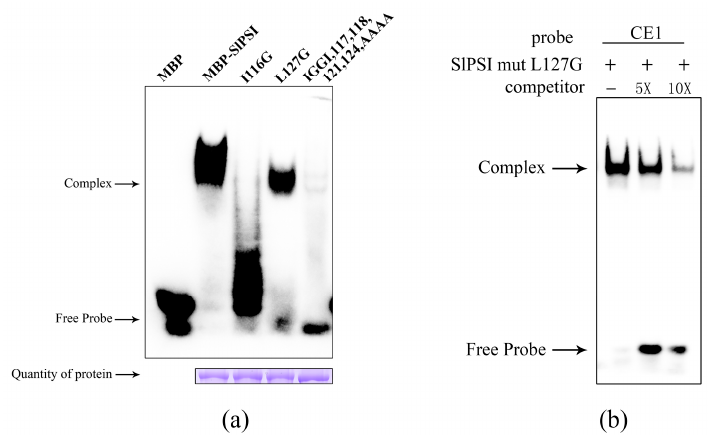
Figure 5. EMSA of wild-type SlPSI and three kinds of potentially key amino acid mutant SlPSI proteins. ( a ) MBP-BmPSI was set as the positive control. The signal intensity of the complex stood for the abilities of different proteins to interact with the CE1 probe. ( b ) Cold competition EMSA experiment between CE1 and SlPSI mutL127G.